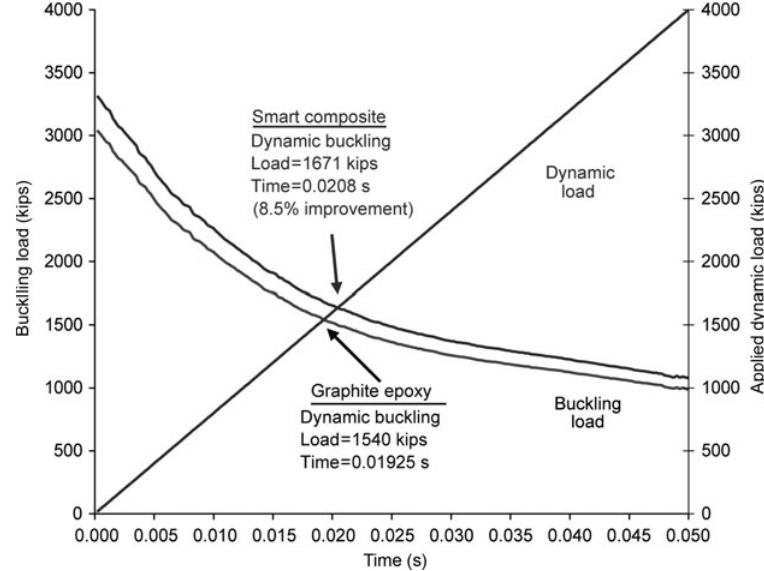
Figure 5 Estimation of dynamic buckling load of smart and graphite epoxy composite shells. (1 kip = 4.45